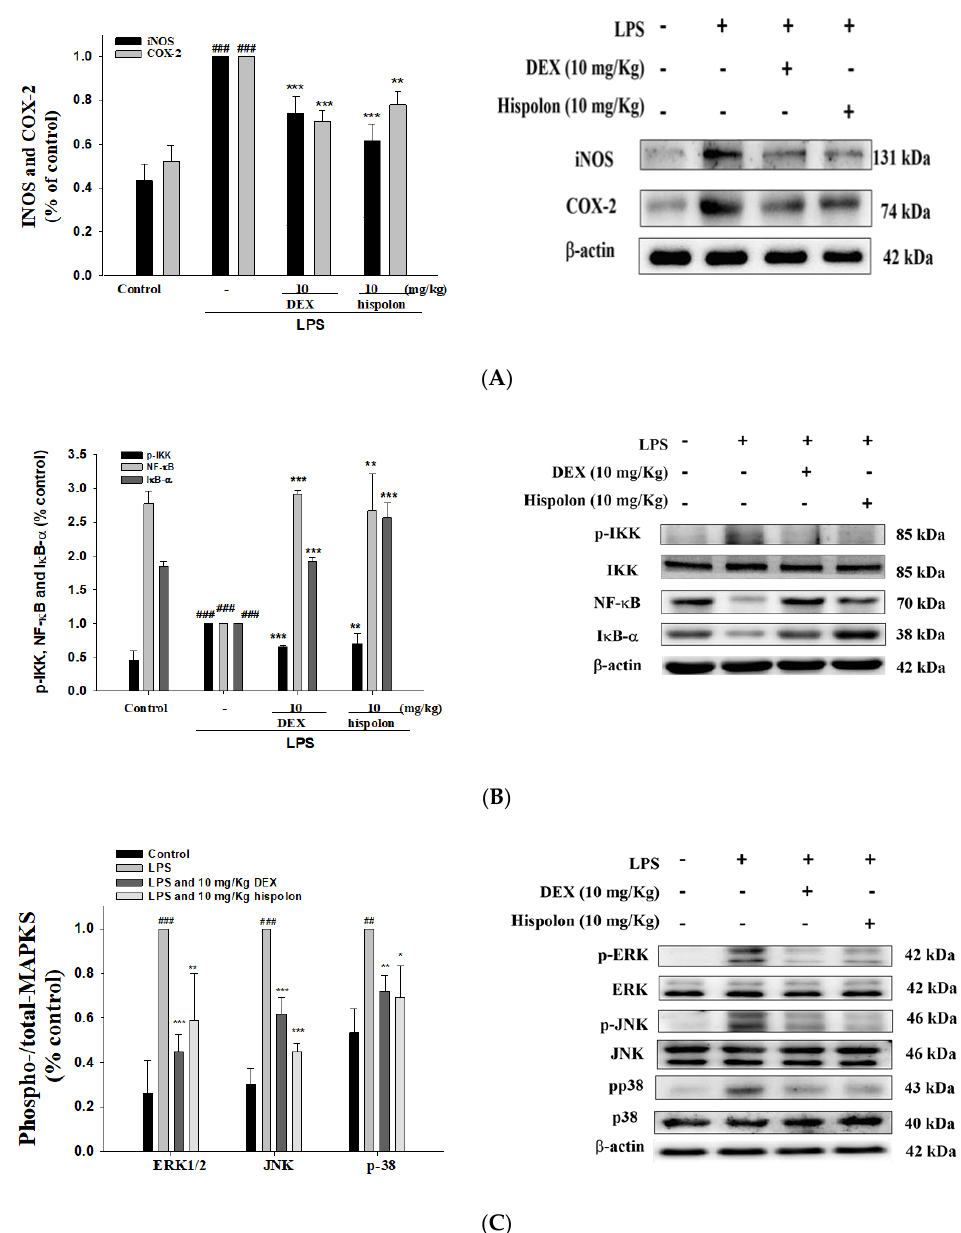
Figure 4. Effects of hispolon on the activation of ( A ) iNOS, COX-2, ( B ) IκB - α, NF - κB and ( C ) the phosphorylation of MAPK axis in lung tissue of LPS-induced acute lung injury (ALI) mice. Lung tissue extracts were subjected to Western blot analysis using antibodies for iNOS, COX- 2, IκB - α and NF- κB and MAPK phosphorylation. Data are represented as means ± S.E.M. (n = 3). ### p < 0.001 versus the control group. * p < 0.05, ** p < 0.01 and *** p < 0.001 versus the LPS group.